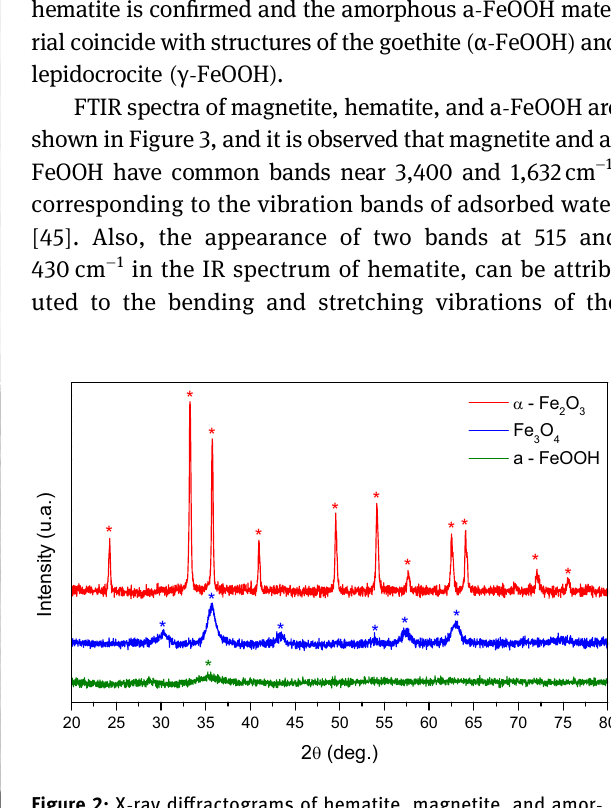
Figure 2: X - ray di ff ractograms of hematite, magnetite, and amor - phous oxide, a - FeOOH. On each di ff raction plane, the plane corre - sponding to the JCPDS pattern is placed with asterisks for each